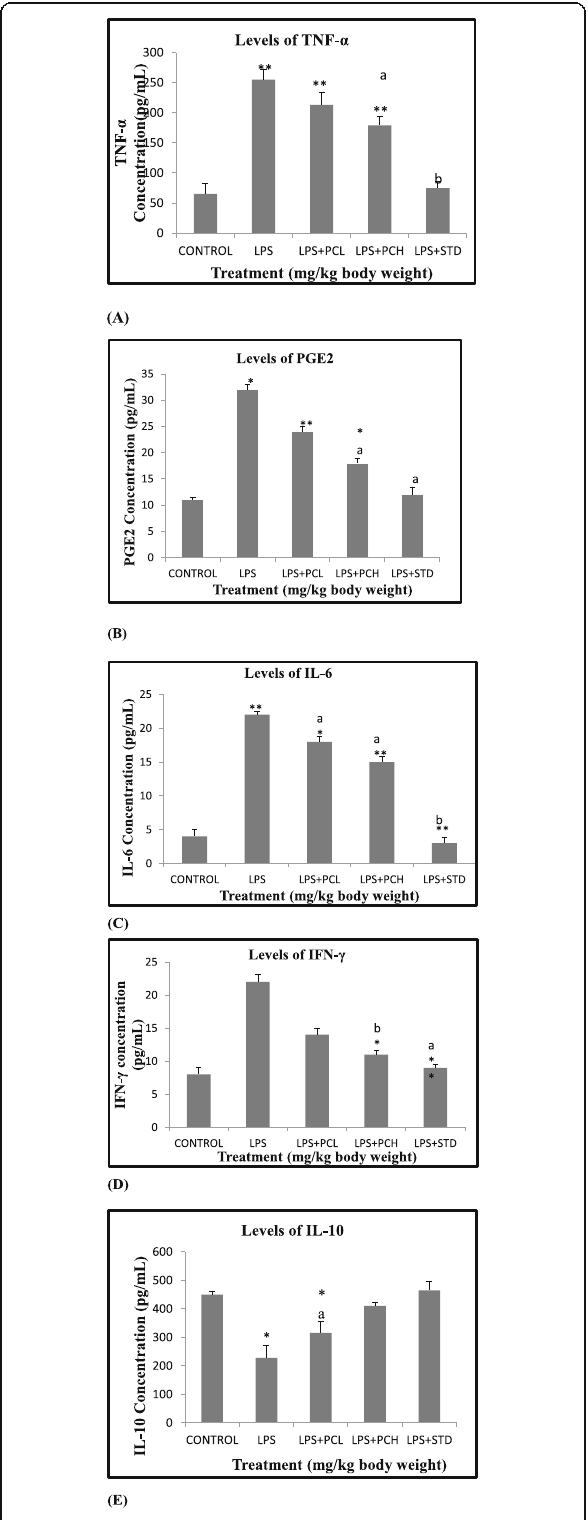
Fig. 1 Graphical Representation of levels of Cytokines: ( a ) TNF- α , ( b ) PGE 2 ( c ) IL-6, ( d ) IFN- γ and ( e ) IL-10 in Liver tissues of male Swiss albino mice. STD- Standard dose; PCL – Prosopis cineraria low dose; PCH- Prosopis cineraria high dose. Values are represented as mean ± SD (n = 6). *p < 0.05, **p < 0.001 v/s control group (C); ap < 0.05, bp < 0.001 v/s LPS treated